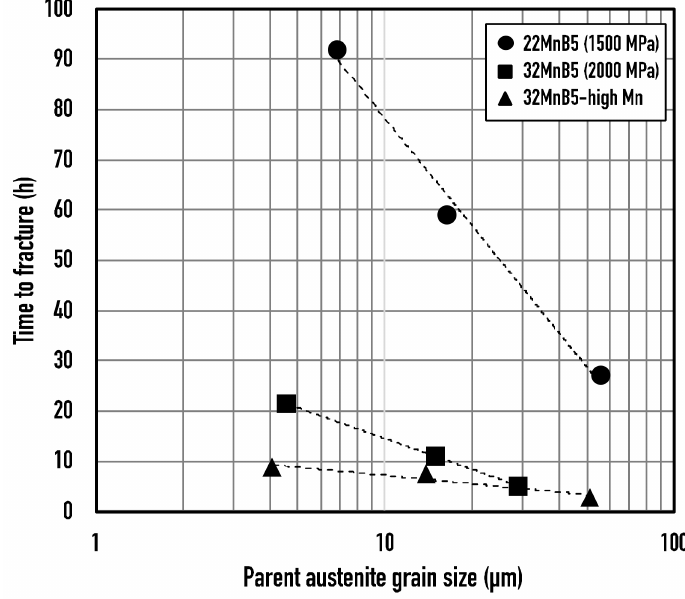
Figure 16. Delayed fracture behavior of as-quenched manganese–boron steels (without niobium microalloying) as a function of parent austenite grain size modified by variation of the re-austenitizing